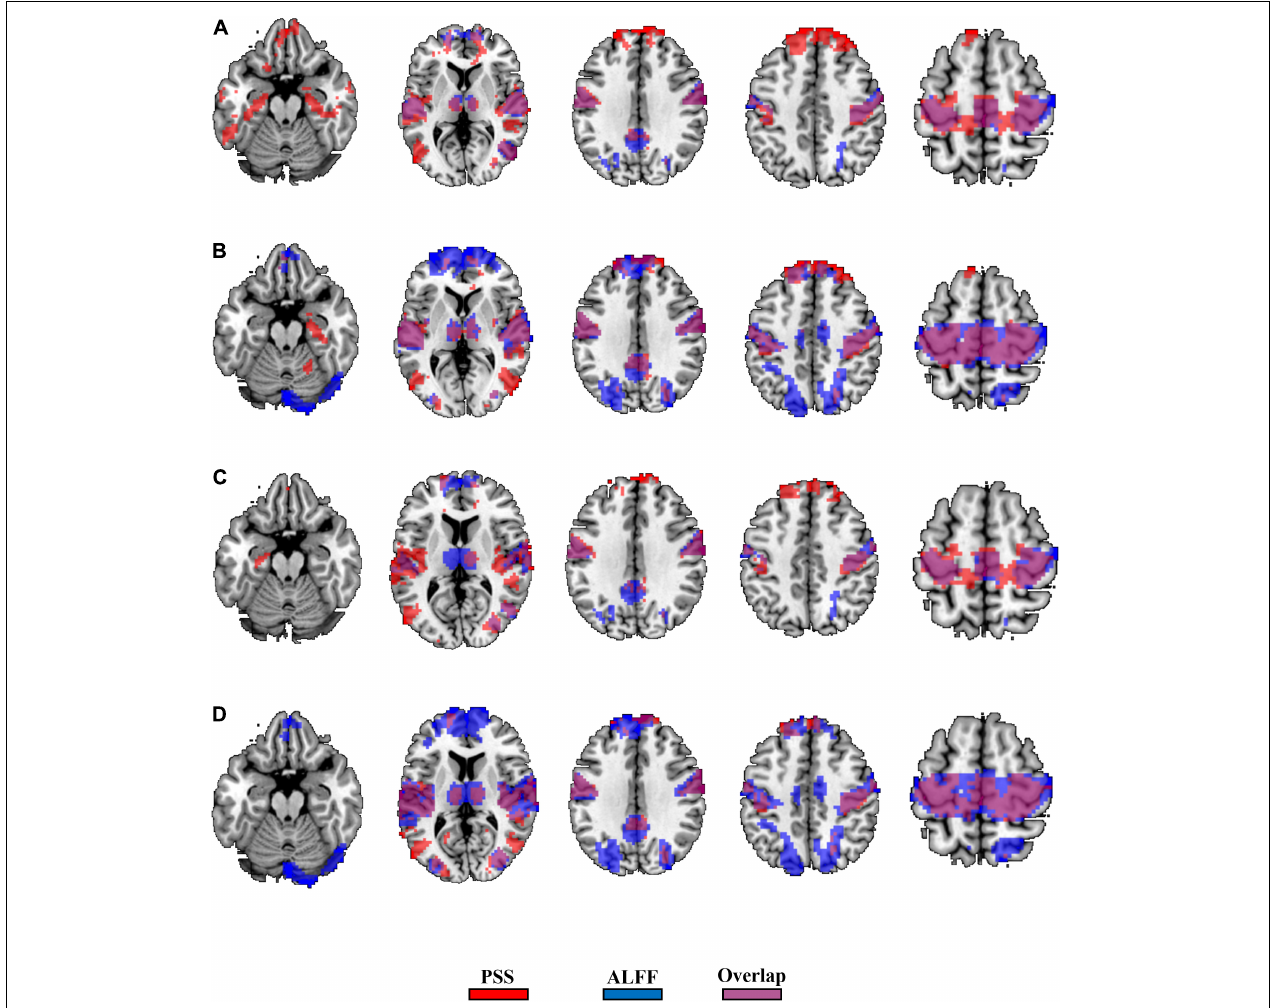
FIGURE 10 | Binary spatial overlap between the EC–EO differences using the PSS and ALFF (0.01–0.1 Hz). Panel (A) shows the spatial overlap of the EC–EO difference using the PSS (linear coefficient b) and ALFF (0.01–0.1 Hz) with group Z-transformation. Panel (B) shows the spatial overlap of the EC–EO difference using the linear coefficient b and ALFF (0.01–0.1 Hz) with individual Z-transformation. Panel (C) shows the spatial overlap of the EC–EO difference using the PSS (power-law slope b’) and ALFF (0.01–0.1 Hz) with group Z-transformation. Panel (D) shows the spatial overlap of the EC–EO difference using the PSS (power-law slope b’) and ALFF (0.01–0.1 Hz) with individual